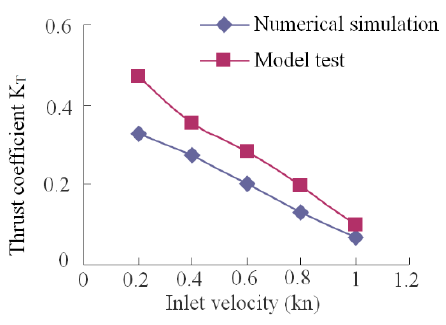
Figure 7. Rotation speed at 1000 rpm.